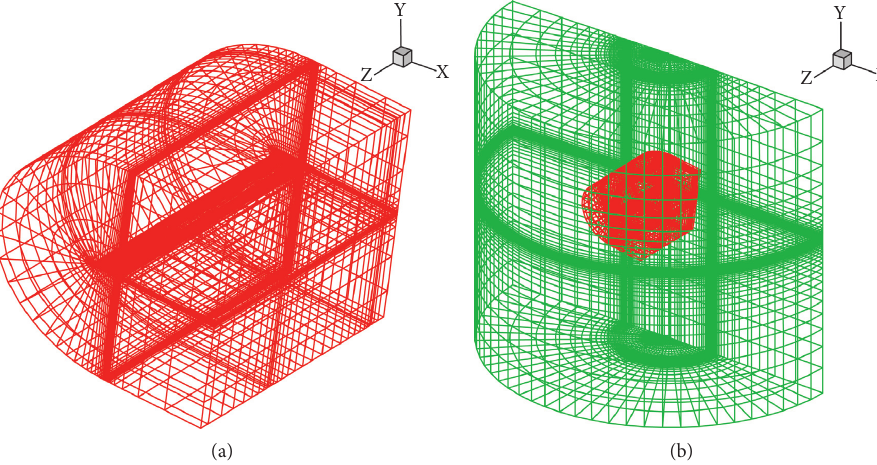
Figure 14: Overset grid sketch for Caradonna-Tung rotor. (a) Rotor grid. (b) Overset grids with rotor grid and background grid.